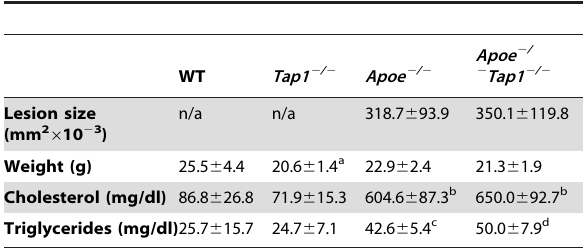
Table 1. Lesion size, weight, plasma cholesterol and triglycerides at 14 weeks of age.